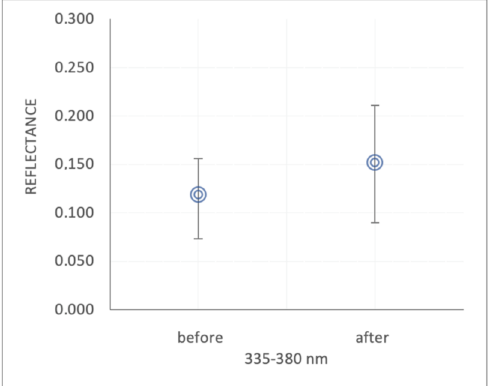
Figure 2. Median and quartile range of reflectance at the wavelength of 335–380 nm in the group of women undergoing microdermabrasion, before and after the